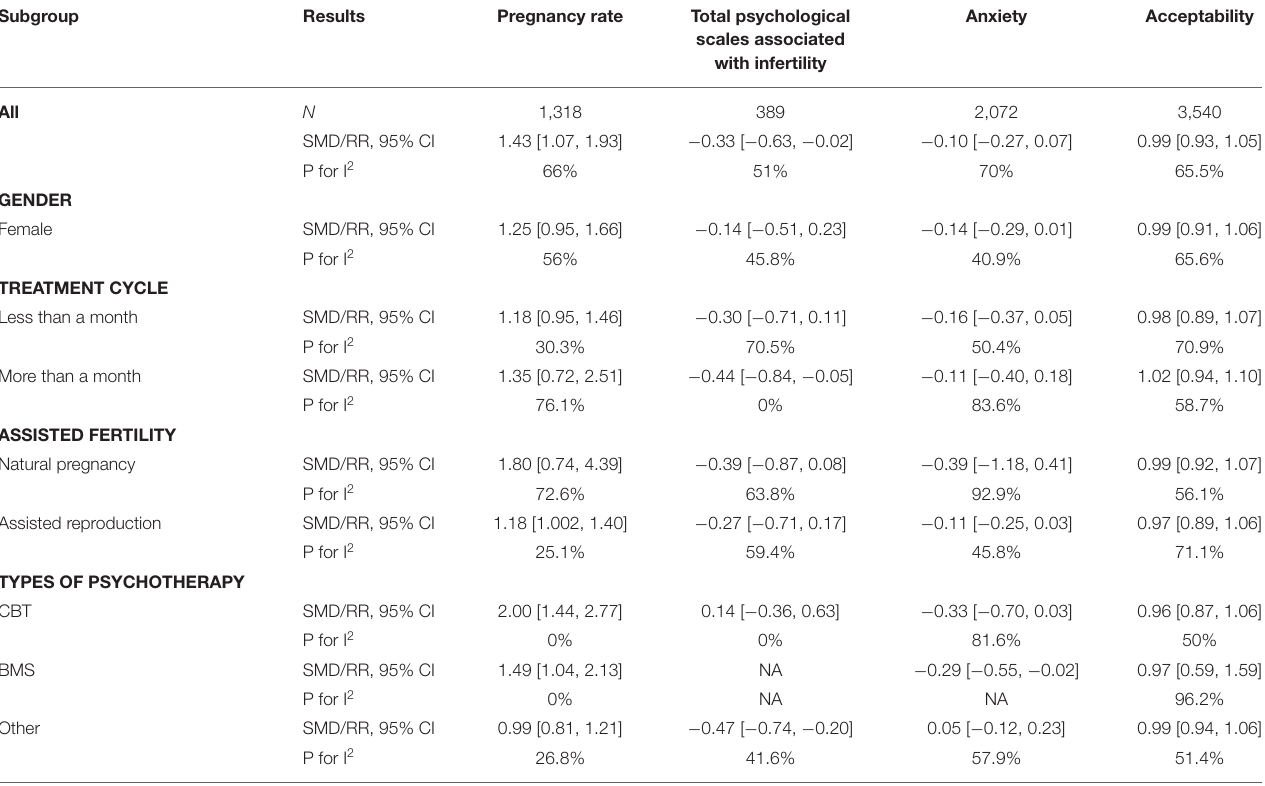
TABLE 4 | Subgroup analysis of primary outcomes based on gender, adjuvant therapy, treatment cycle, and types of psychotherapy. Subgroup Results Pregnancy rate Total psychological